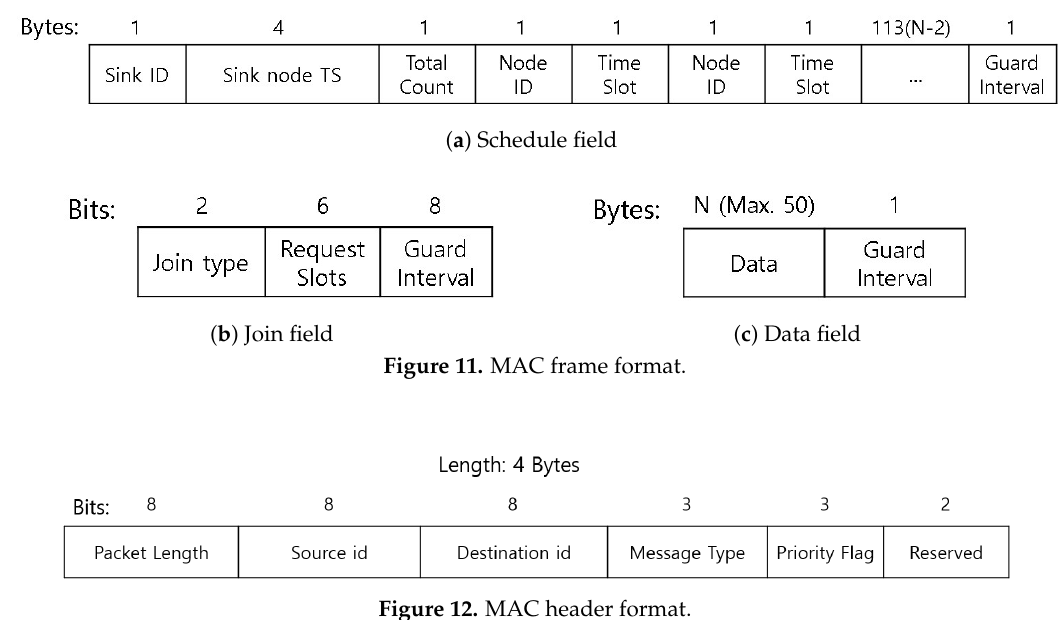
Figure 12. MAC header